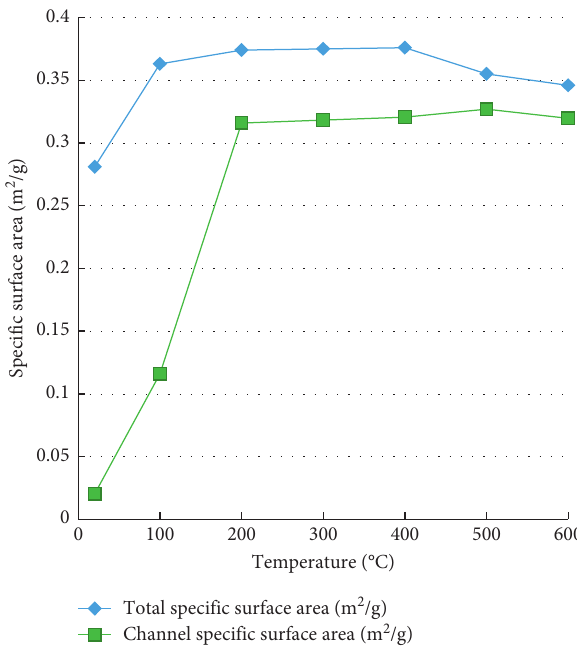
Figure 6: Specific surface area and channel-specific surface area under different